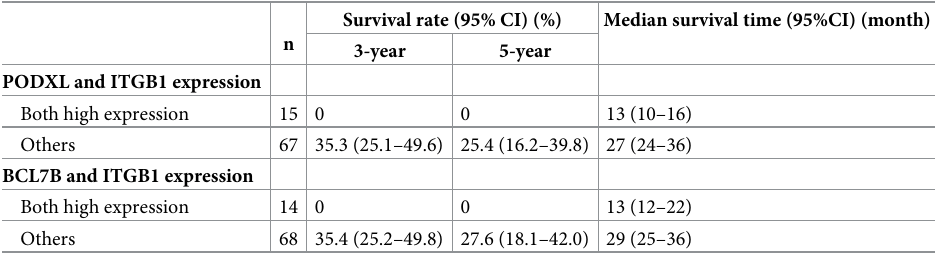
Table 8. The 3-year and 5-year survival rates and median survival times at stage II �